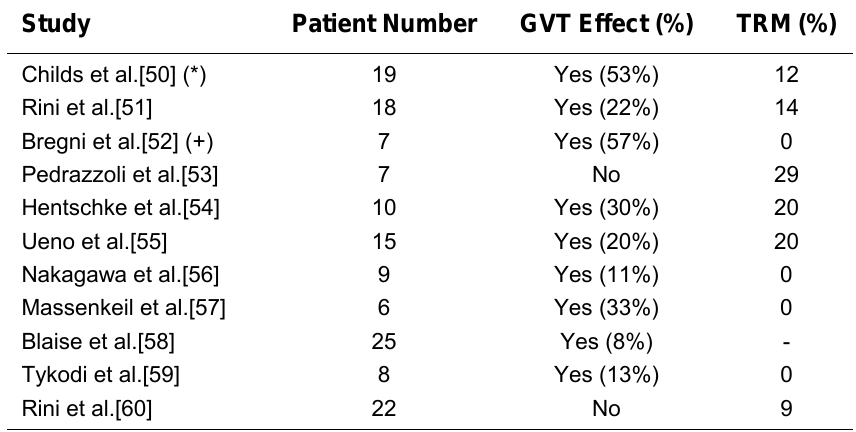
Transplant Related Mortality (TRM), GVT Response, and Patient